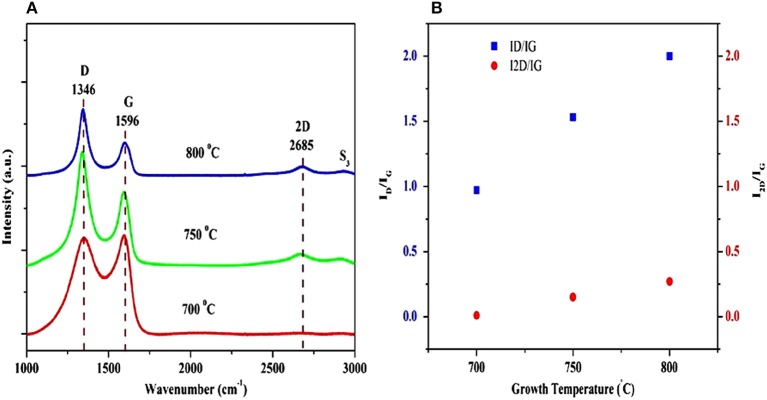
(A) Raman spectra of graphene films deposited on Ni/Si substrate at three different growth temperatures; (B) ID/IG and I2D/IG intensity ratios of graphene layers as a function of the growth temperature [Reproduced from Kumar et al. (2017) with permission of Springer]. (B) shows the ID/IG and I2D/IG ratios as a function of growth temperature. Clearly, the intensity ratios ID/IG and I2D/IG increased with the increase in growth temperature. The I2D/IG ratio for the graphene film deposited at 750°C was 0.15, confirming the formation of multi-layer graphene (7–8 layers). The I2D/IG ratio for graphene films grown at 800°C was 0.27, corresponding to few-layer graphene (4–5 layers).